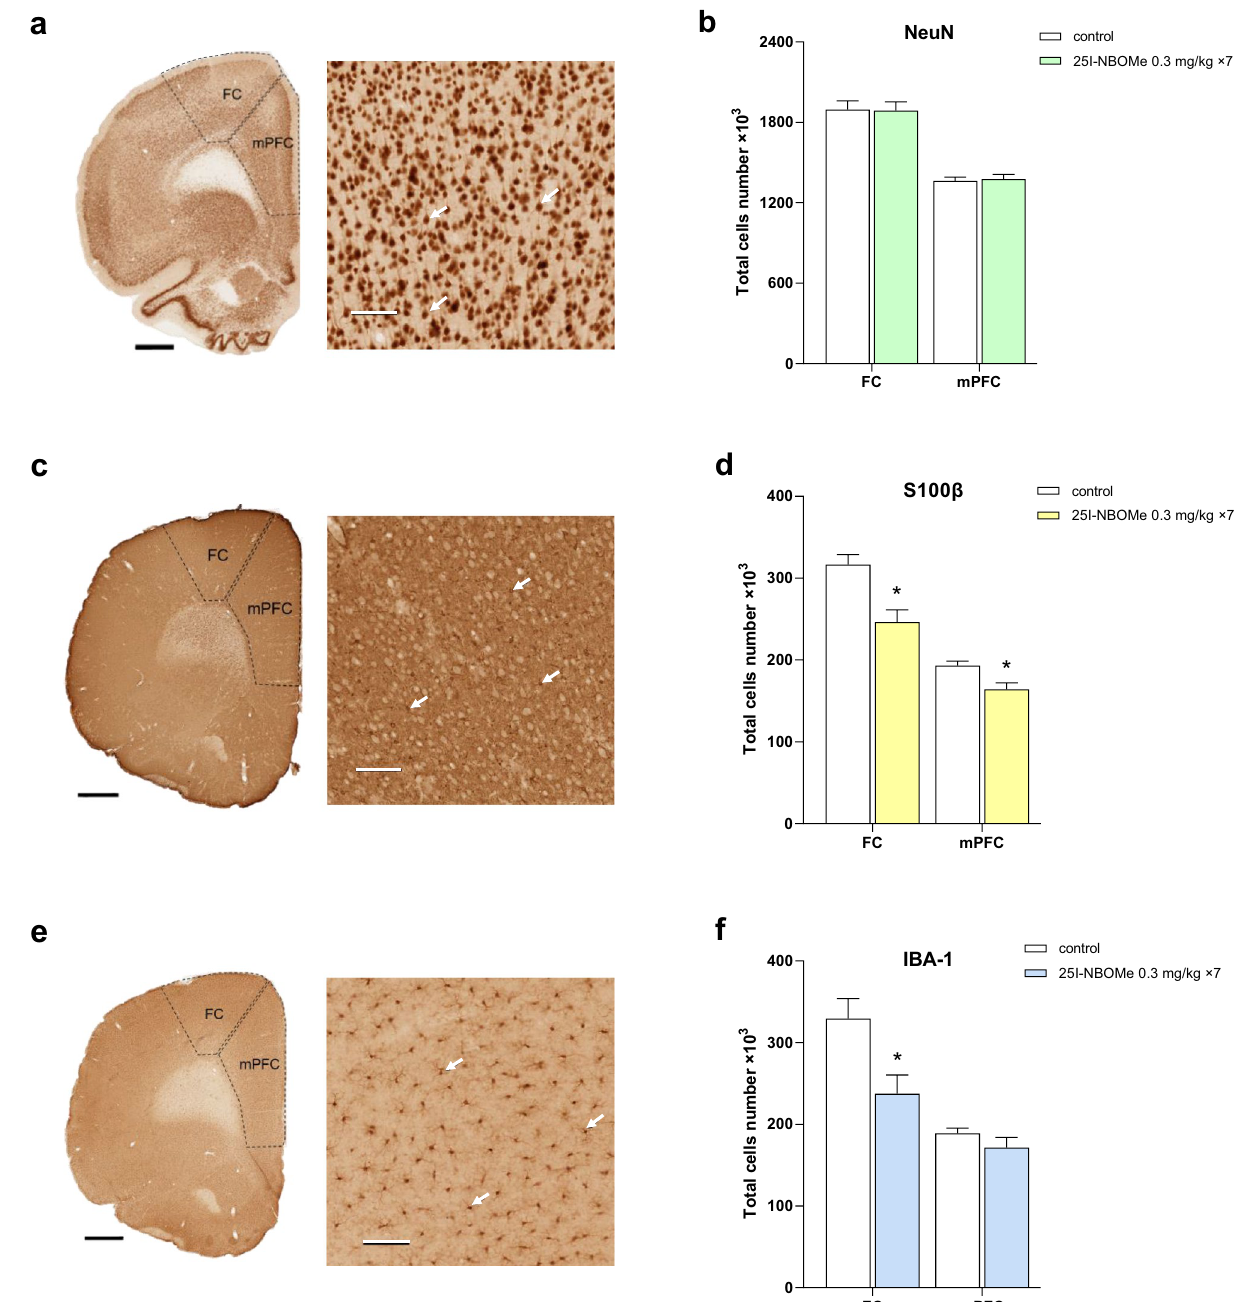
Figure 3. The number of neurons and glia cells in the frontal cortex (FC) and medial prefrontal cortex (mPFC) (n = 6 per group). Light photomicrographs that were immunoprobed for NeuN ( a ), S100β ( c ), IBA-1 ( e ) and examined for the number of immunopositive neurons ( b ), astrocytes ( d ), and microglia ( f ). The graph bars indicate the mean ± SEM. The scale bars represent 1 mm and 100 μm. The arrows show examples of cells immunopositive for NeuN, S100β and